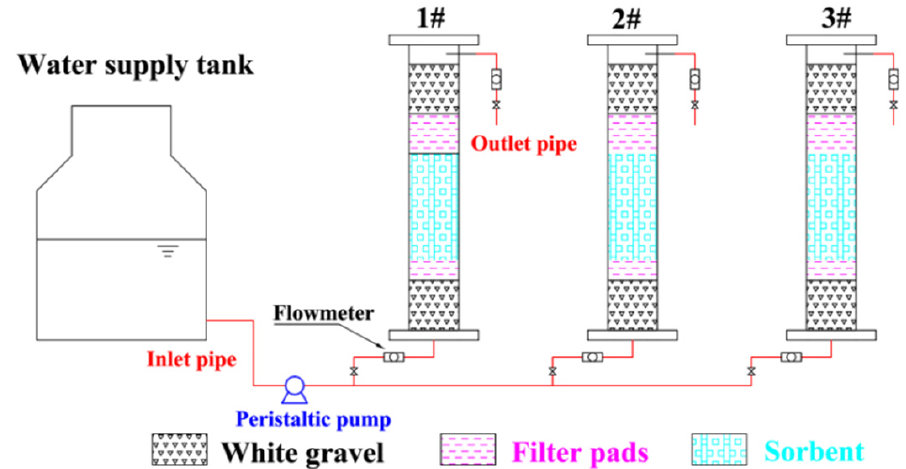
Figure 2. Schematic diagram of the dynamic adsorption device. (1#, 2#, and 3# in the figure are the dynamic adsorption columns under different reaction conditions.)